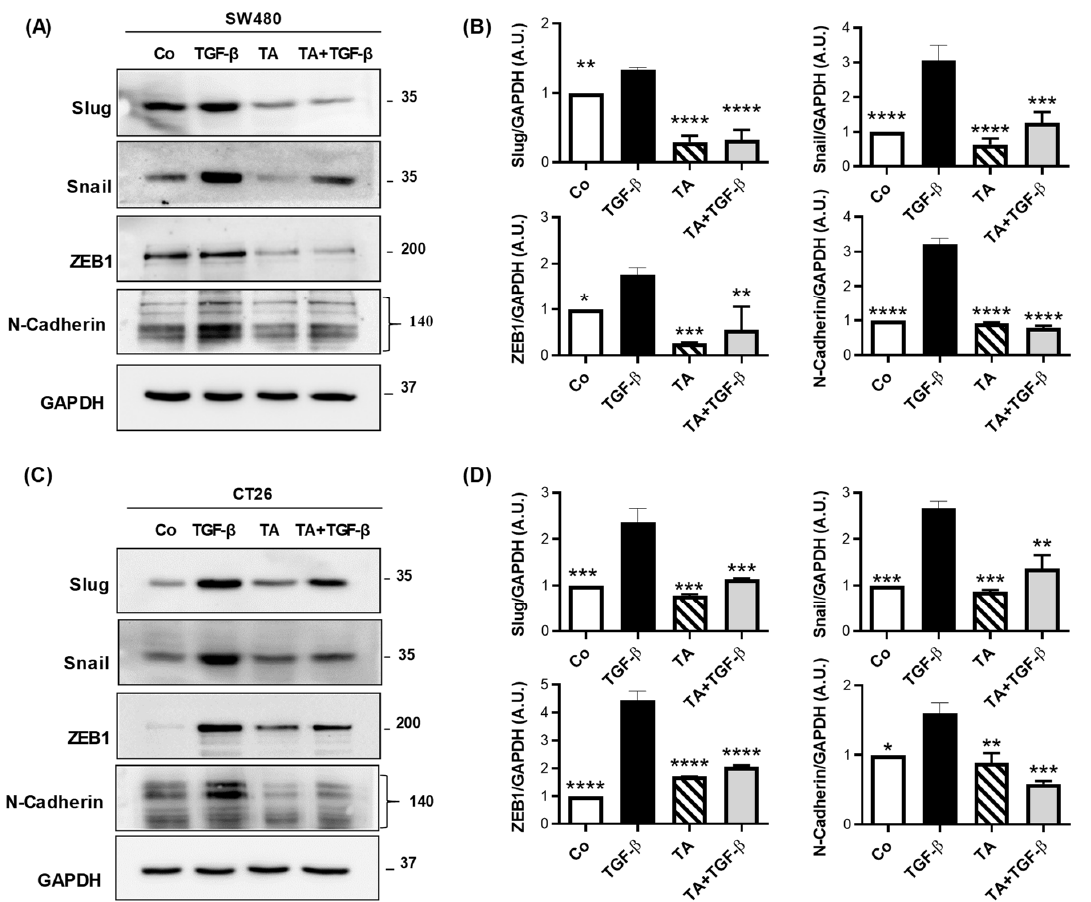
Figure 6. TA inhibits TGF- β -induced mesenchymal marker expression in SW480 and CT26 cells. Serum-starved SW480 and CT26 cells were treated with TA (0.8 µ M), TGF- β (10 ng/mL), or a combi- nation of both (TA + TGF- β ) for 48 h. Vehicle-treated cells served as the control (Co). Representative immunoblot and densitometry quantification analysis of EMT markers Slug, Snail, ZEB1, and N- cadherin in SW480 ( A , B ) and CT26 ( C , D ) after 48 h of treatment. The band intensity was quantified using GAPDH as an internal loading control, and quantification values were normalized to the con- trol. Results are expressed as mean ± SD of 3 independent experiments (n = 3). Statistical significance was determined by one-way ANOVA, followed by Tukey’s test for multiple comparison tests, with * p ≤ 0.05, ** p < 0.01, *** p < 0.001, and **** p < 0.0001, vs. the corresponding TGF- β 1